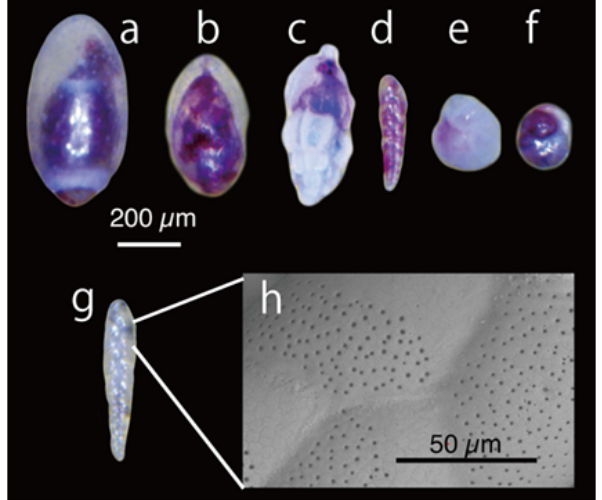
Fig. 2. Photomicrographs of Rose Bengal-stained specimens of an- alyzed foraminifera (a–g) . (a) Chilostomella ovoidea , (b) Globob- ulimina auriculata , (c) Uvigerina akitaensis , (d) Brizalina pacifica , (e) Islandiella norcrossi , (f) Takayanagia delicata , (g) dead B. paci- fica . (h) Scanning electron micrograph of B. pacifica .